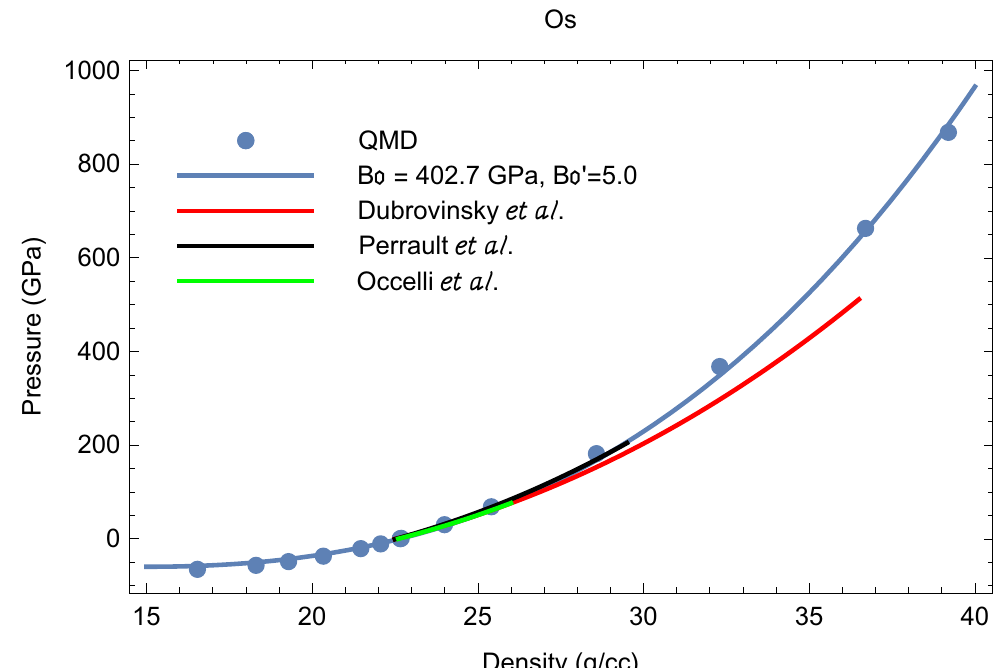
Figure 2. The T = 0 Os EOS from VASP compared to the experimental 300 K 3rd-order Birch-Murnagan Figure 2. The T =0 Os EOS from VASP compared to the experimental 300 K 3rd-order Birch-Murnagan (BM3) EOSs from different literature sources [18,31,34]. The pressure ranges of the experimental EOSs (BM3) EOSs from different literature sources [17,31,34]. The pressure ranges of the experimental EOSs are those in which they were are those in which they were measured.